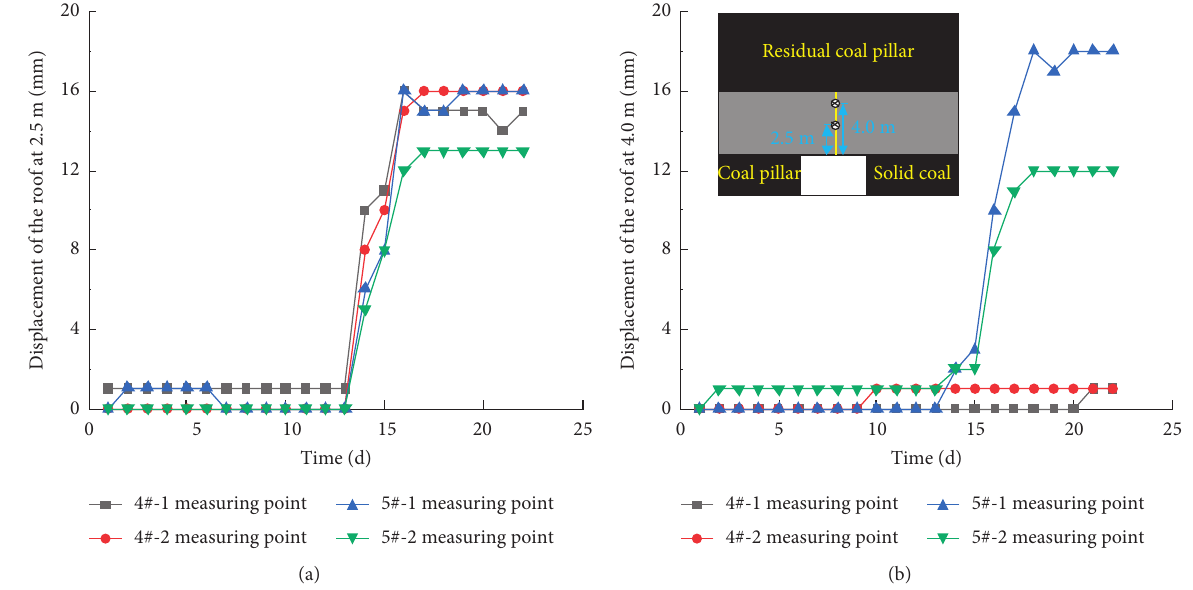
Figure 8: Displacement curve of the deep roof: (a) displacement of the roof at 2.5m; (b) displacement of the roof at